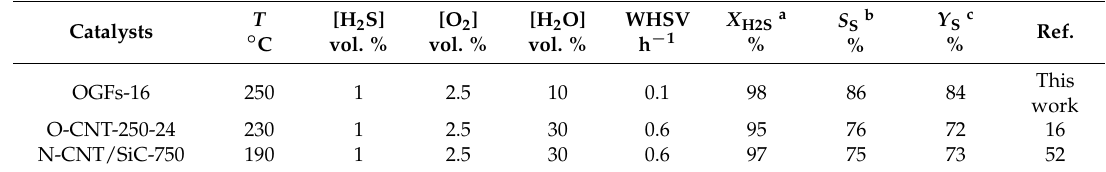
Table 3. Selective oxidation of H 2 S to sulfur over different metal-free